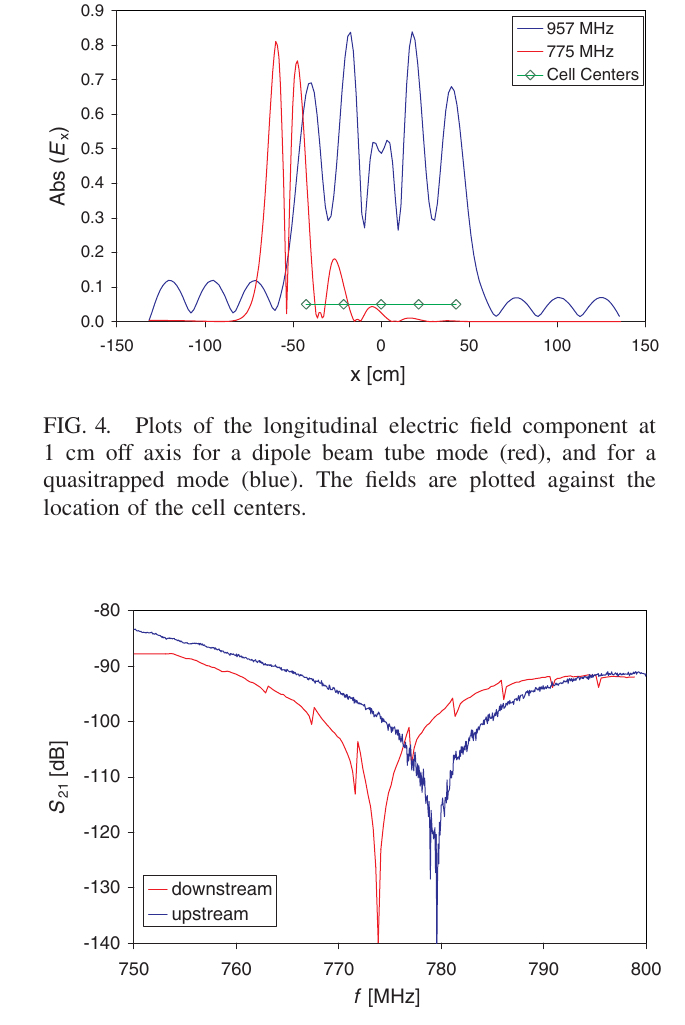
FIG. 5. Resonances in the upstream (blue) and downstream (red) beam tube. The latter houses the FPC. Its additional resonant structure is caused by the FPC’s waveguide connection to the rf source.